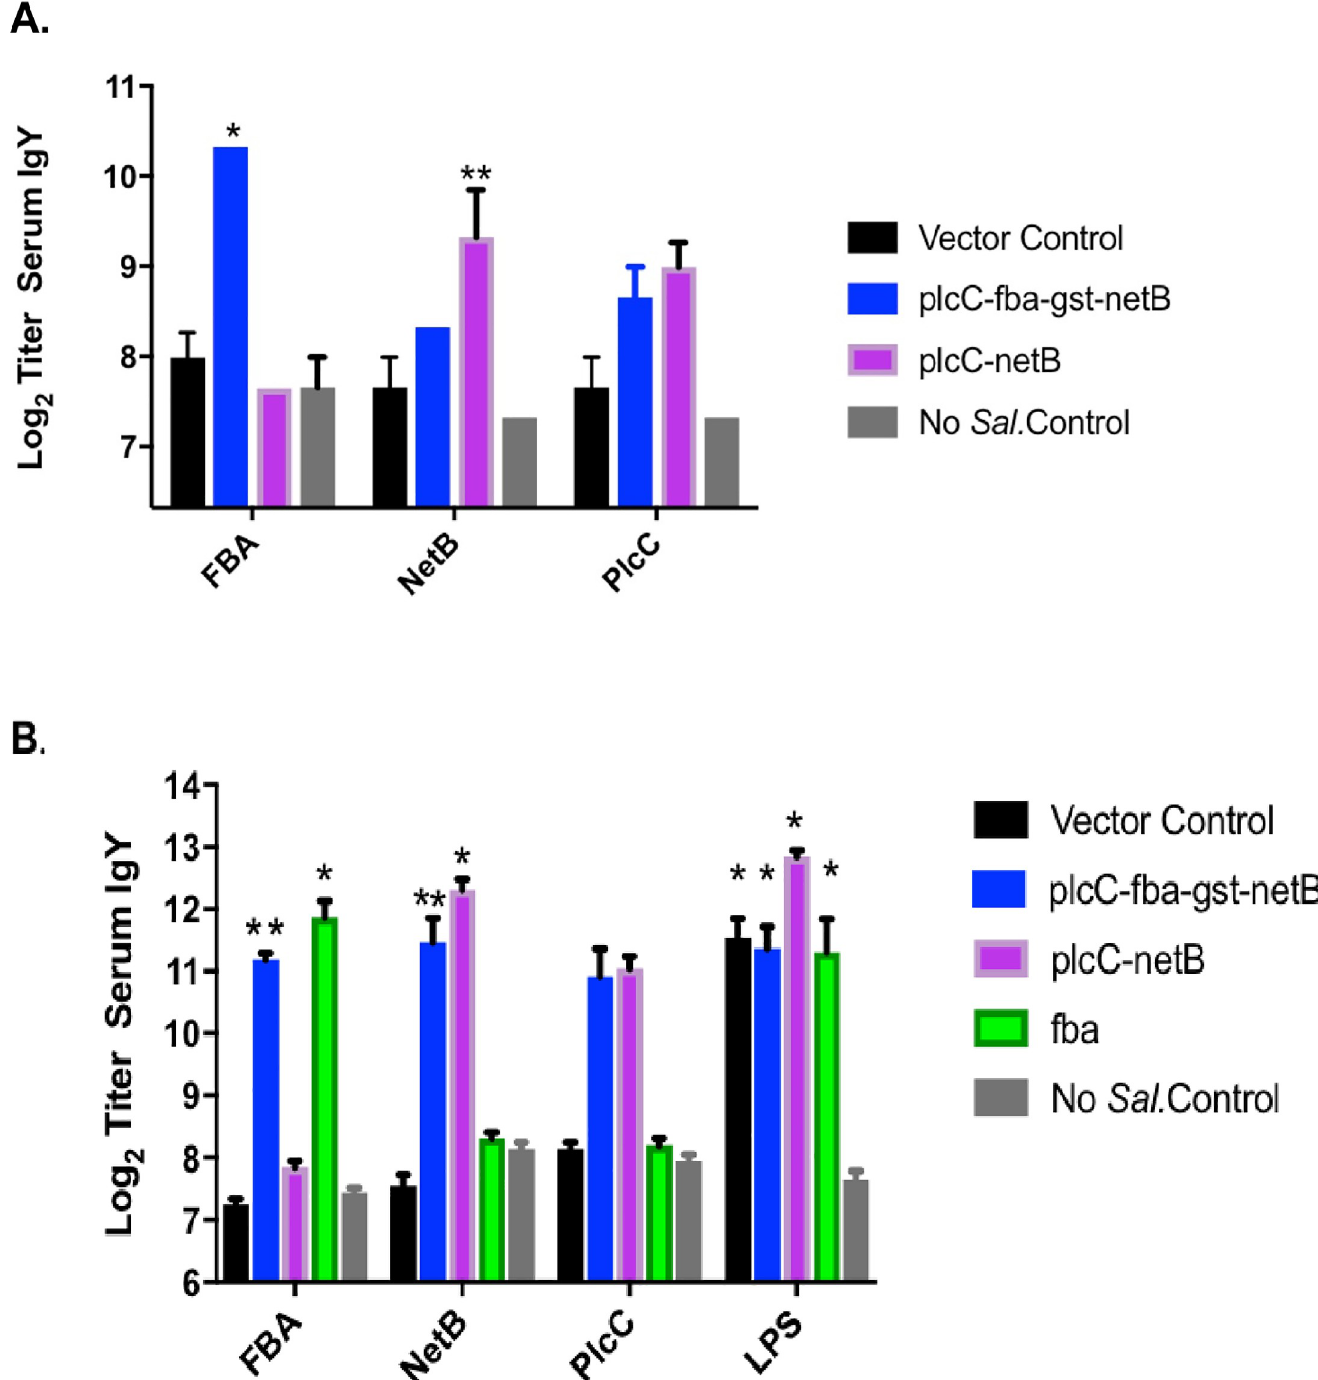
Fig 2. Serum antibodies against C . perfringens and Salmonella antigens in vaccinated and non-vaccinated birds as determined by ELISA. (A) Experiment 1; (B) Experiments 2/3. Differences in responses compared to non-vaccinates and vector-only controls are indicated � , P < 0.0001; �� , P < 0.02. LPS responses were compared to non-vaccinated